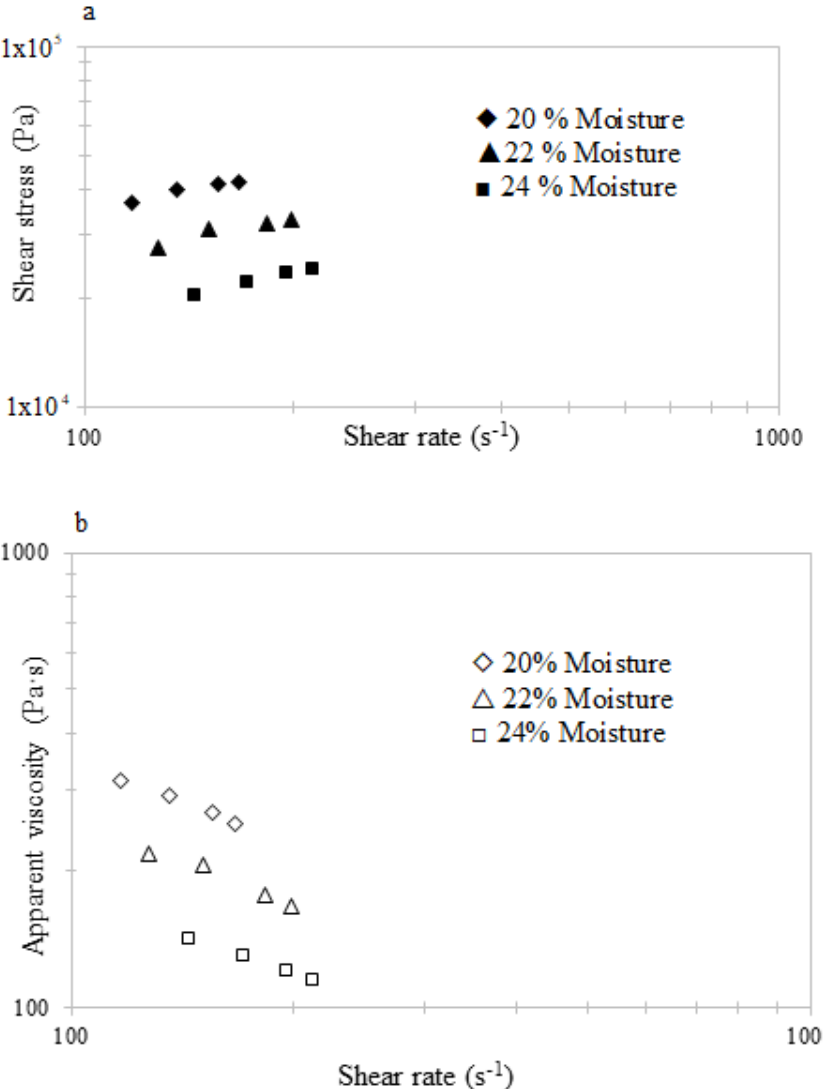
Figure 3. Effect of the moisture content variation on the shear stress ( a ) and apparent viscosity ( b ) in the treatments studied with a protein flour content of 35% and 115 °C.